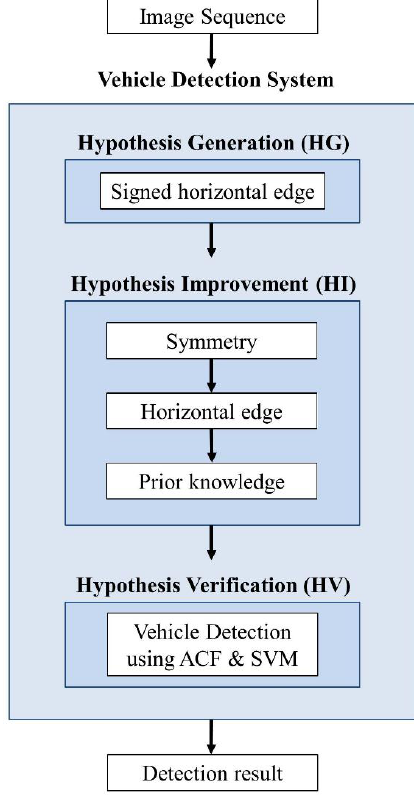
Figure 3. Flow chart of the proposed vehicle detection system.